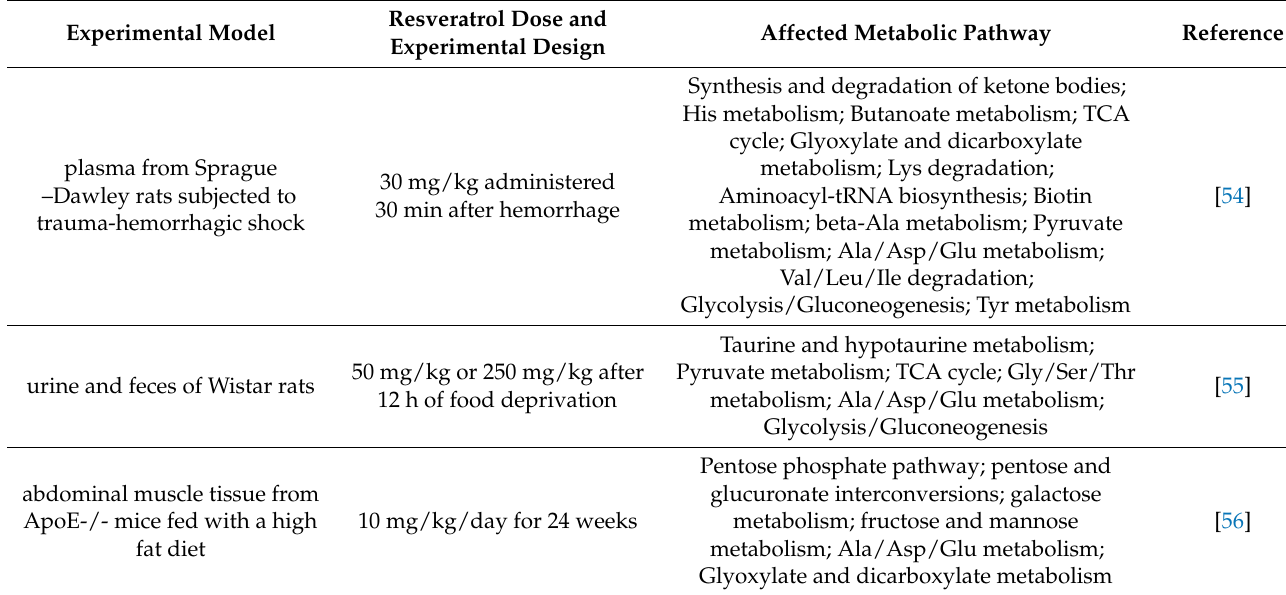
Table 3. Resveratrol-related changes in metabolic pathways. Pathways were identified using the MetaboAnalyst 5.0 software based on resveratrol-affected